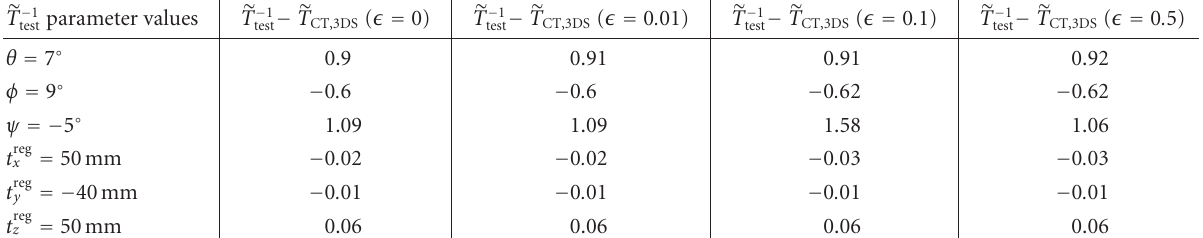
Table 1: Inherent accuracy of the registration algorithm according to the data down-sampling parameter (cid:3) . (cid:2) T − 1 parameter values test